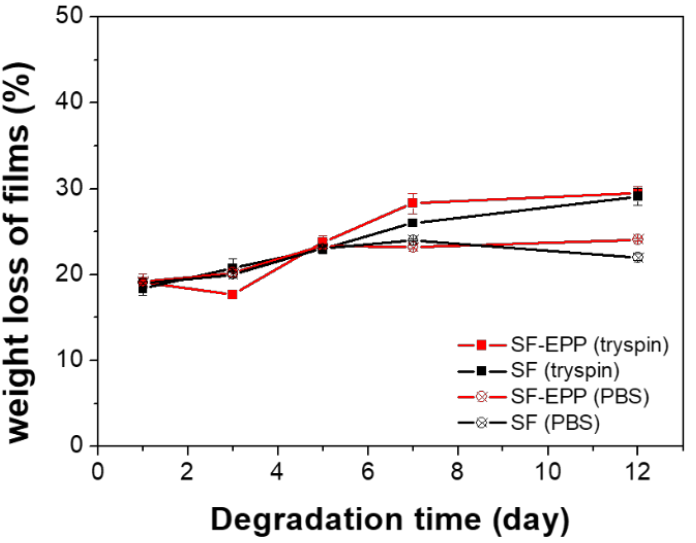
Figure 4. Enzymatic degradation profiles compared with PBS dissolution profiles of pure SF (black lines) and SF-EPP films (red lines).